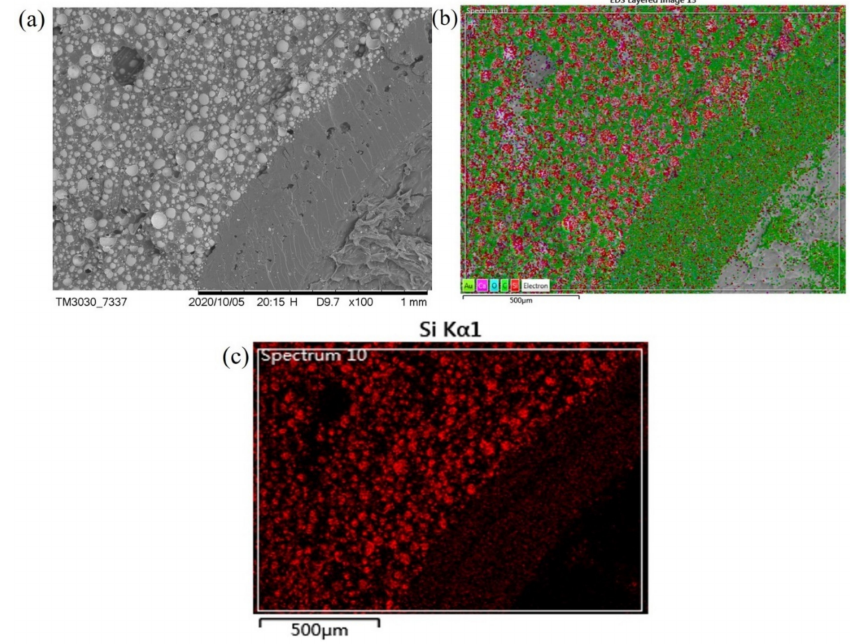
Figure 18. ( a ) SEM image and ( b , c ) EDS of the sphere